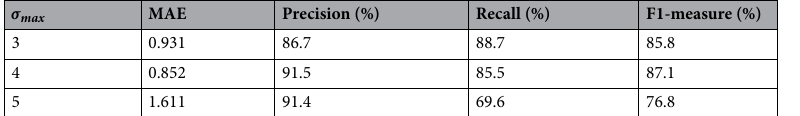
Table 2. Influence of the σ max in counting and detection of M. flexuosa palms-trees ( σ min = 1 and stages T = 4 were adopted).